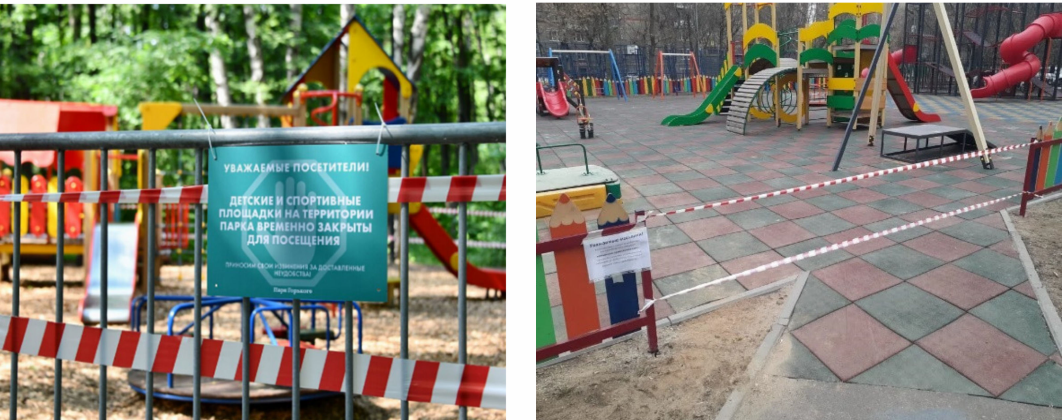
Figure 3. Closure of many parks and public spaces in Moscow (first line) and neighbourhood UGS (playgrounds, second line) due to COVID-19 restrictions, March–May 2020 (signboards indicating prohibiting visits to parks and playgrounds): Park Zaryadye ( top left ), Park VDNKh ( top right ), playgrounds in the multi-story housing complexes in the southern district of Moscow ( bottom images ). Photos: E. Kosenkov.